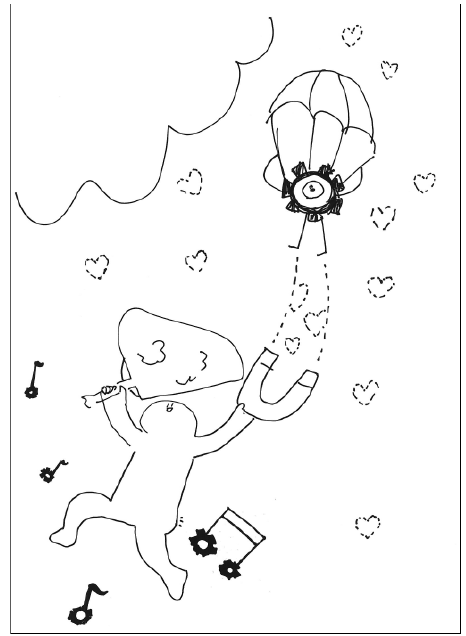
Figure 9. Work by D3 Moderate Depression.